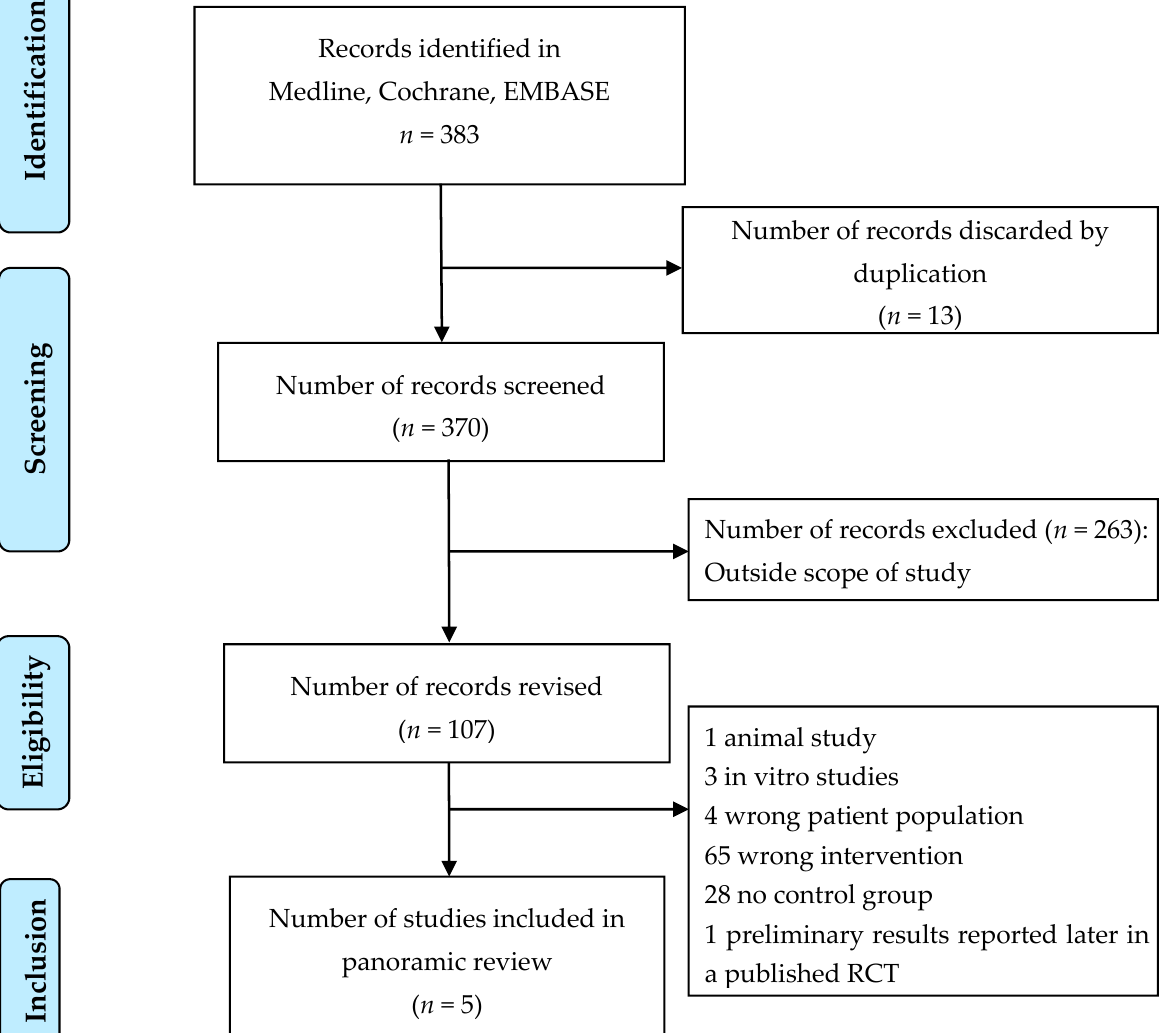
Figure 1. Flowchart of the search strategy and study selection.